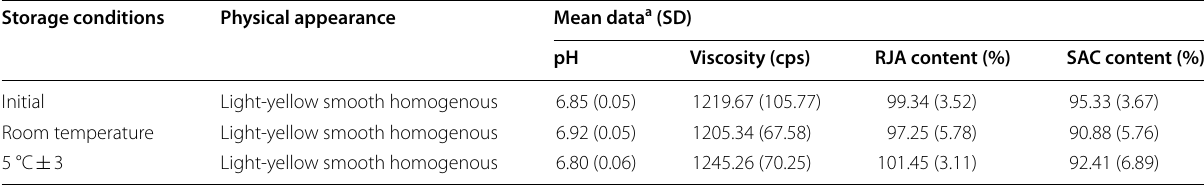
Table 5 Stability data of the selected medicated Na alginate‑based emulgel formula (MF3) after storage at room temperature and under refrigeration (5 3 °C) for 3 months ±